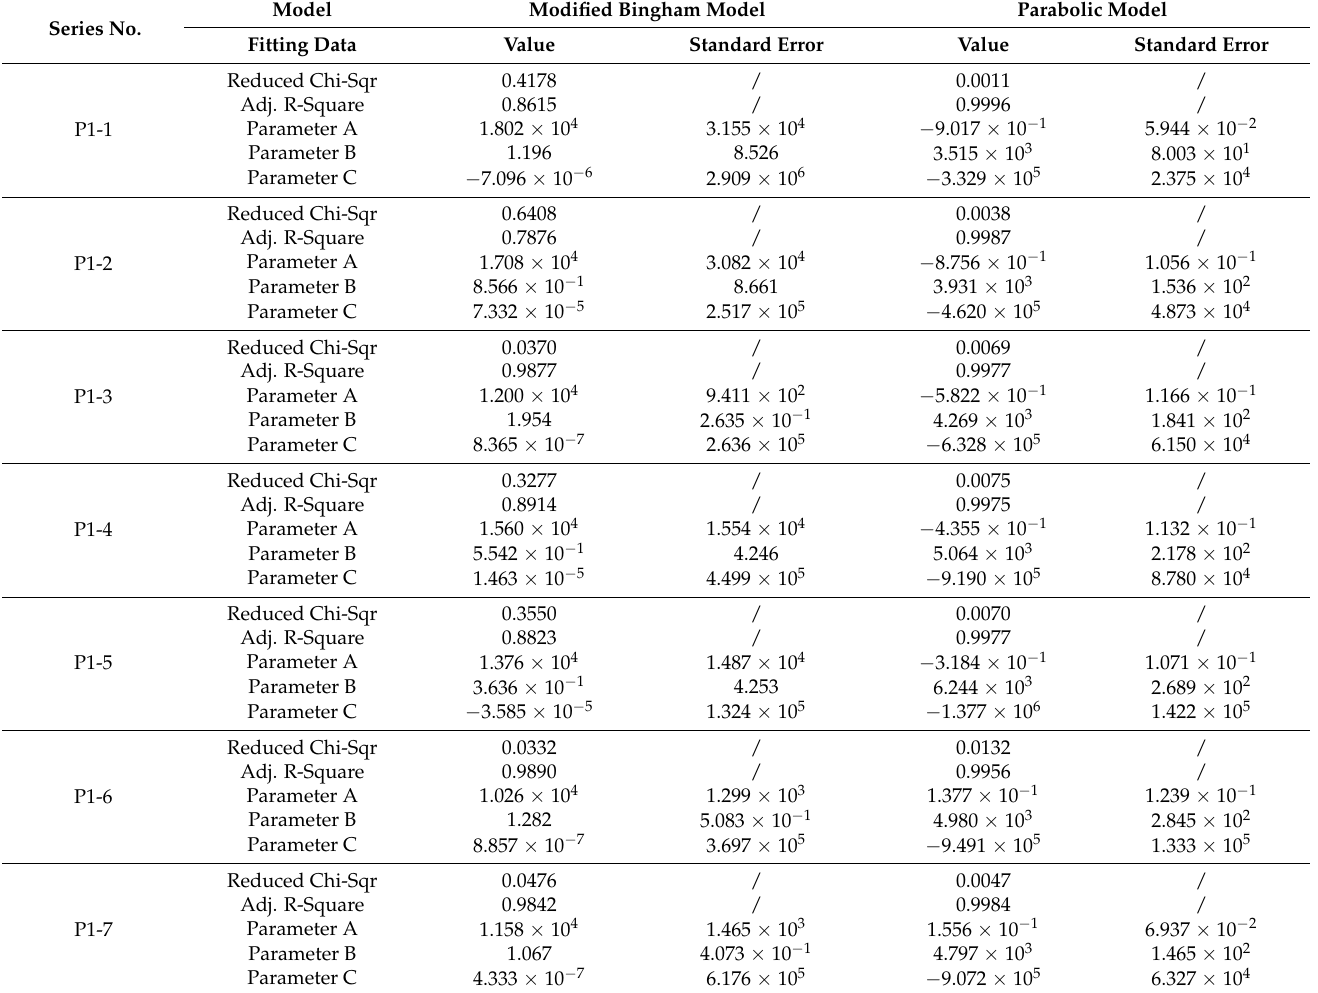
Table 3. Fitting data of P1 based on modified Bingham model and parabolic